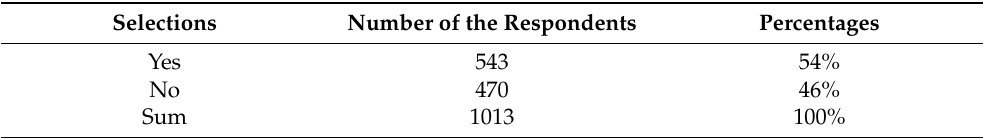
Table A16. Do you think that the distribution ledger recording the trading of cryptocurrencies has higher advantages than the central ledger in the future (single-choice question)?